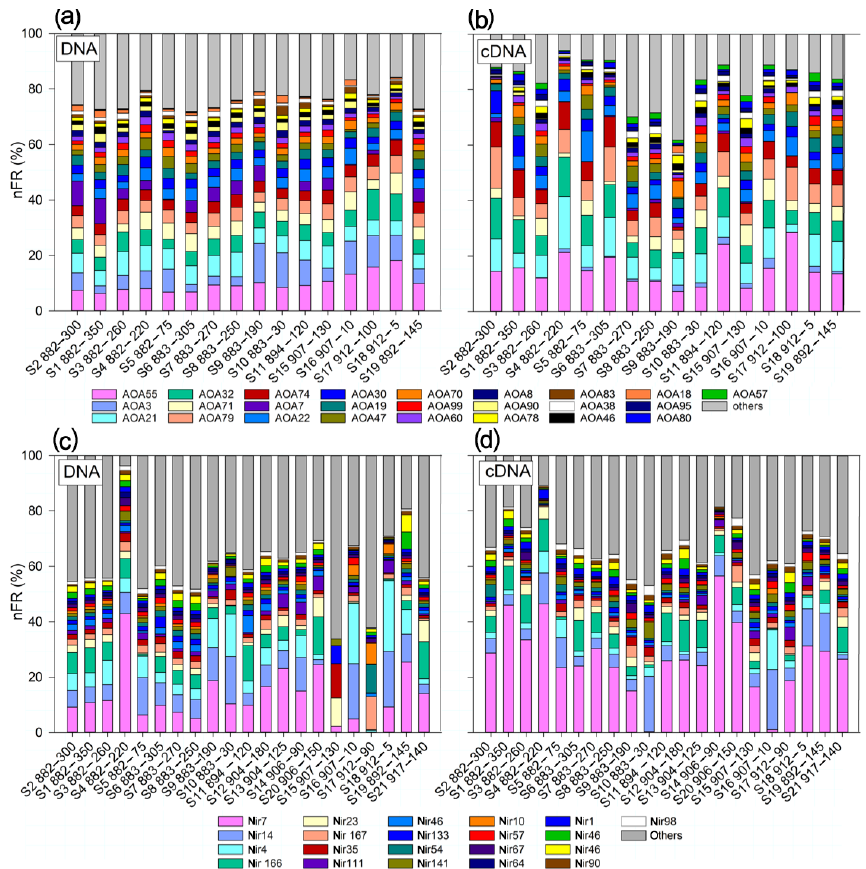
Figure 8. Stacked bar plot of community composition of AOA amoA archetypes (a, b) and nirS archetypes (c, d) . Only archetypes over 1% contribution are shown. (a, c) Total community composition (DNA). (b, d) Active community composition